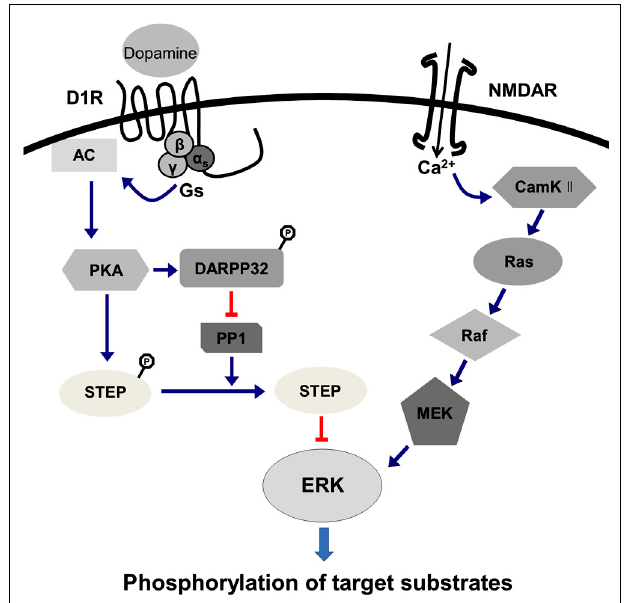
FIGURE 1 | D1 receptor-mediated ERK activation signaling pathway. D1 receptor-mediated ERK singling involves interaction with the NMDA glutamtate receptor (see text), which is expressed predominantly in the striatum.The stimulation of D1 receptors is not able to mediate ERK phosphorylation per se, but rather requires endogenous glutamate (Pascoli etal., 2011). Stimulation of D1 receptors increases calcium influx through NMDA receptors, which involves phosphorylation of the NMDA receptor NR2B subunit by a Src-family tyrosine kinase (Pascoli etal., 2011).This increased calcium influx activates a number of signaling pathways, including calcium and calmodulin-dependent kinase II (CamKII), which can activate ERK via the Ras-Raf-MEK cascade (Fasano etal., 2009; Shiflett and Balleine, 2011; Girault, 2012). Upon D1 receptor activation, activated PKA can mediate phosphorylation of DARPP-32 and phosphorylated DARPP-32 can act as potent inhibitor of the protein phosphatase (PP-1), which dephosphorylates another phosphatase, the striatal-enriched tyrosine phosphatase (STEP). Dephosphorylation of STEP activates its phosphatase activity, thus allowing STEP to dephosphorylate ERK. DARPP-32 also acts upstream of ERK, possibly by inhibiting PP-1, which prevents PP-1 from dephosphorylating MEK, the upstream kinase of ERK.Thus, D1 receptor activation increases ERK phosphorylation by preventing its dephosphorylation by STEP, but also by preventing the dephosphorylation of the upstream kinase of ERK, indicating that D1 receptor-mediated ERK activation involved a complex regulation by phosphatases and kinases in addition to the cross talk with glutamate receptor signaling. Phosphorylation status is only notified for DARPP32 and STEP in this